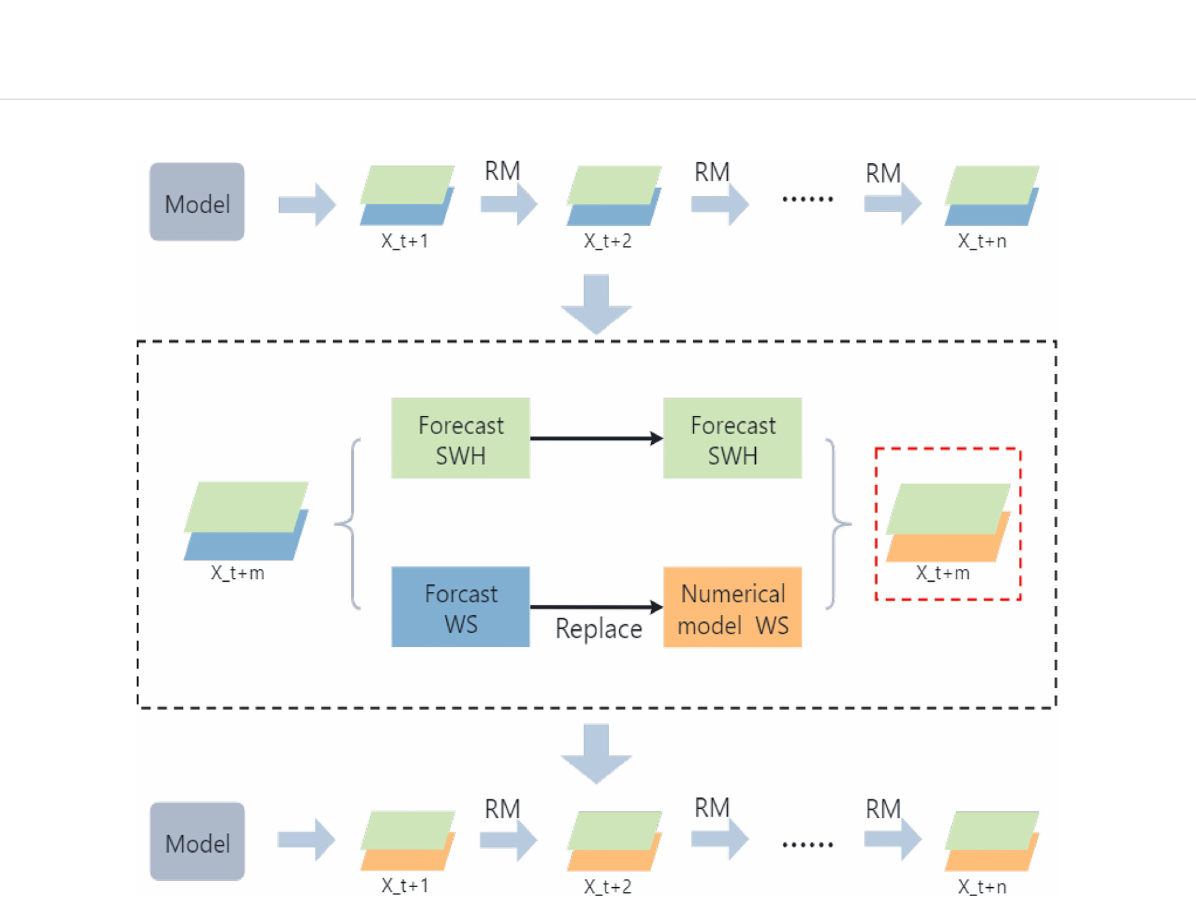
FIGURE 12 The idea of Replace Mechanism. The black dotted box represents the core steps of the RM mechanism, and the red box represents the data obtained through the RM